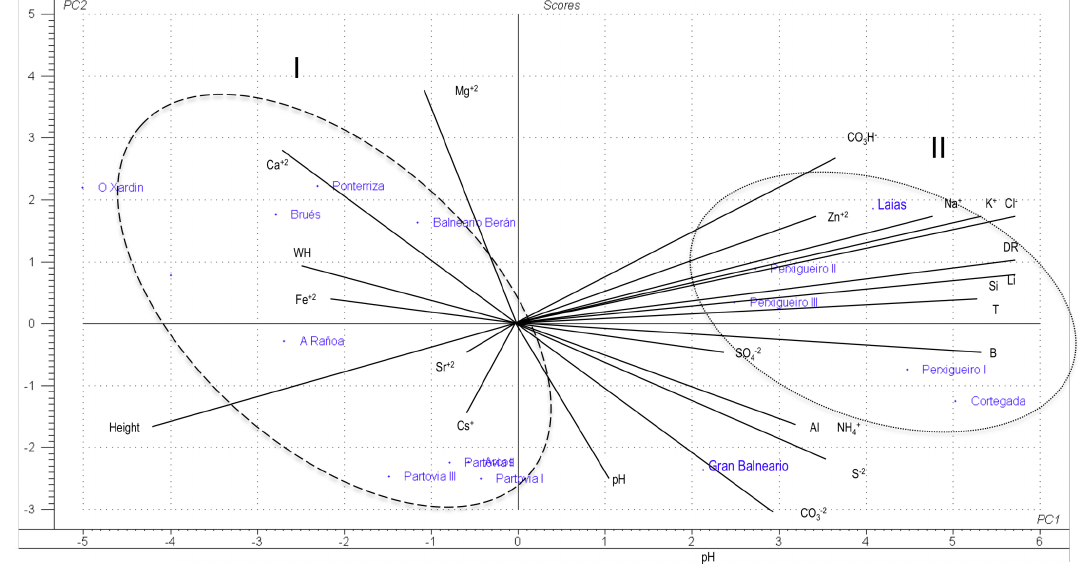
Fig. 3. Prinicpal component analysis on the selected thermal waters. Cluster I, samples with the shortest water-rock contact time, lowest equilibrium temperatures and under-saturated with respect to calcite. Cluster II, samples with longest water-rock contact time, highest equilibrium temperature and super-saturated with respect to calcite.